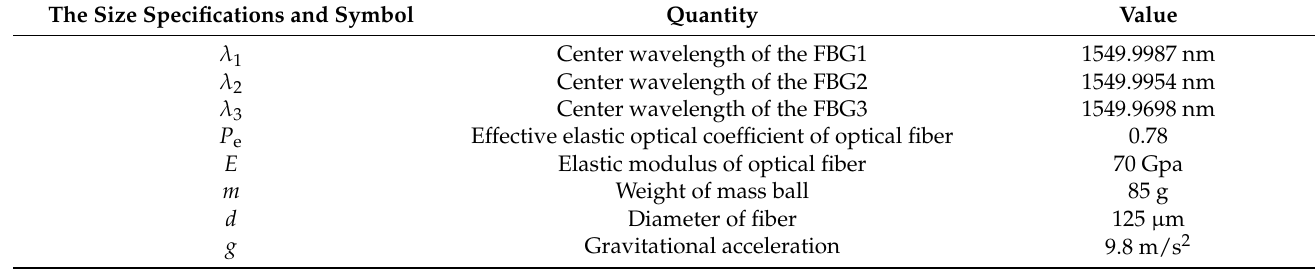
Table 1. Characteristic parameters of the FBG sensor for the pitch and roll angles detection.